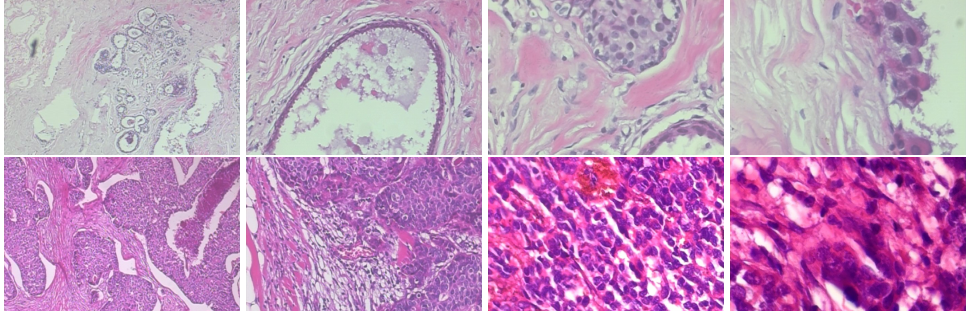
Figure 1. Sample histopathological images. The top row shows benign images at 40 × , 100 × , 200 × , and 400 × (left to right). The bottom row shows malignant images at 40 × , 100 × , 200 × , and 400 × (left to